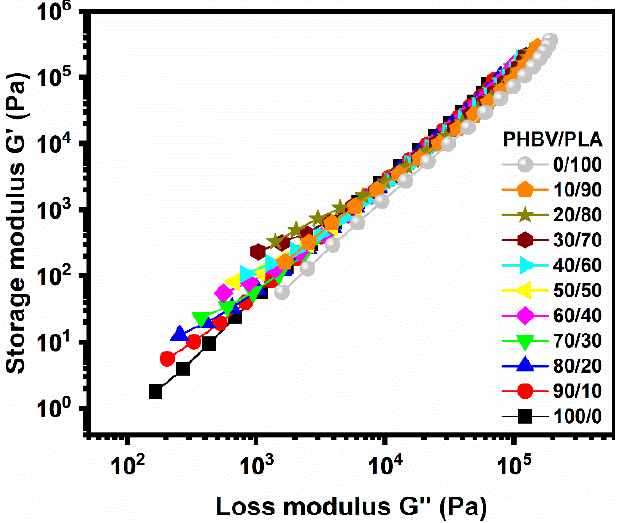
Figure 12. Han plot diagram giving the storage modulus ( G (cid:48) ) versus loss modulus ( G (cid:48)(cid:48) ) for the PLA/PHBV blends at 175 °C.